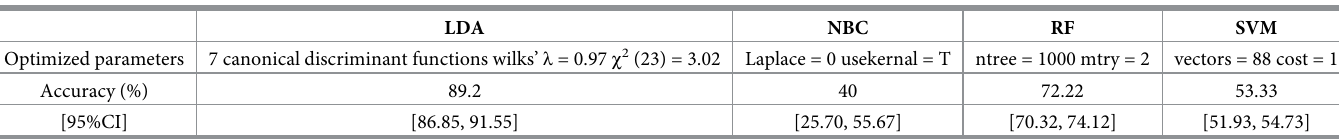
Table 4. Optimized parameters and accuracies of the automatic speaker identification on all speech data based on the four supervised learning algorithms [i.e., lin- ear discriminant analysis (LDA), na ï ve bayes classifier (NBC), random forest (RF), and support vector machine (SVM)]. All seven acoustic parameters were included as the predictor variables.